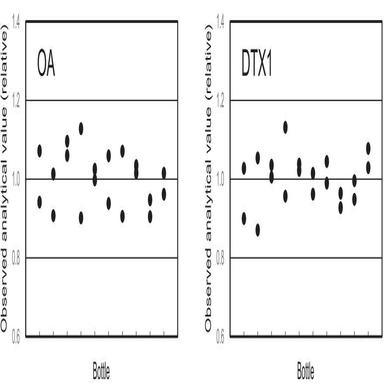
Observed analytical values (relative) of OA and DTX1 in the homogeneity assessment of CRM 7520-a.